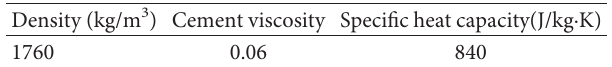
Table 2: Slurry parameters in